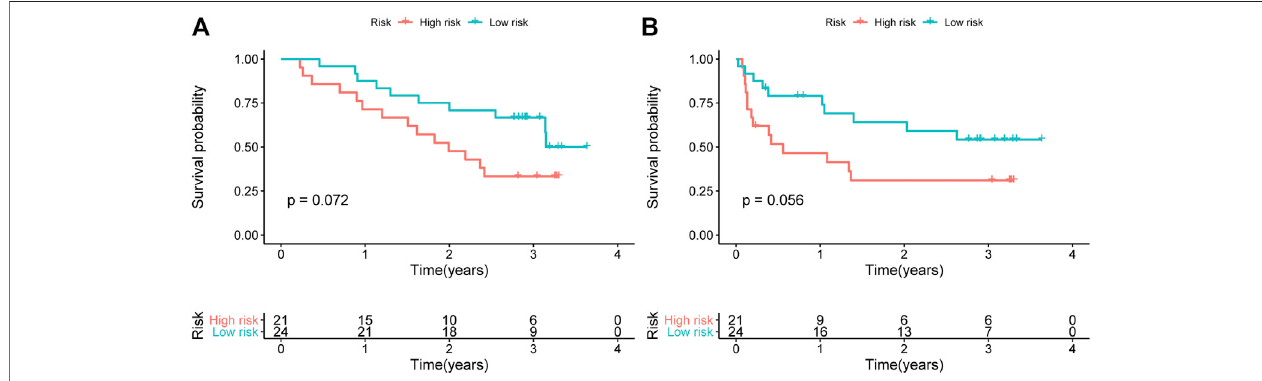
FIGURE 7 | Veri fi ed the expression level of the representative PLOD2/CDKN1B in 45 liver cancer samples. Kaplan-Meier curves of (A) OS and (B) RFS for HCC patients strati fi ed by the signature risk groups in the Tongji